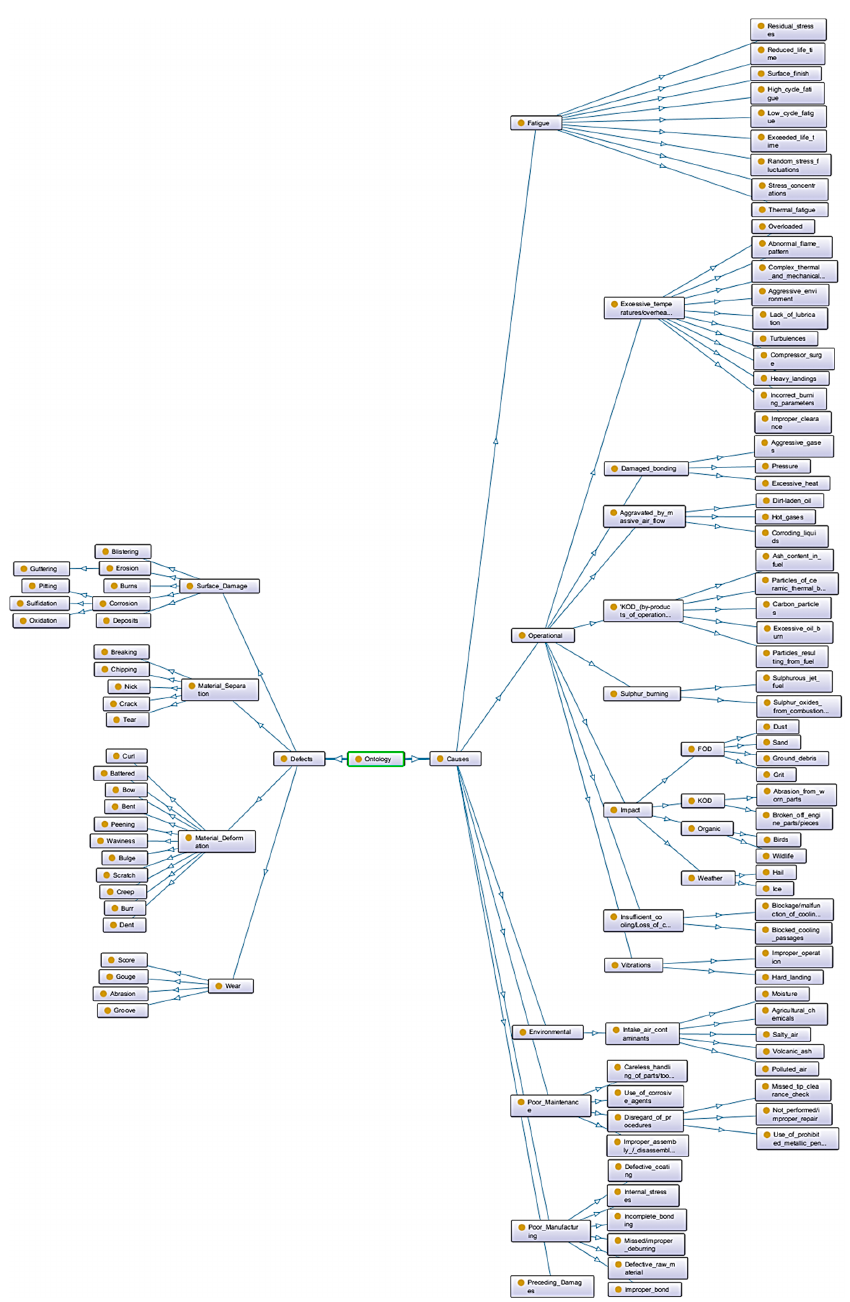
Aerospace 2019 , 6 , x